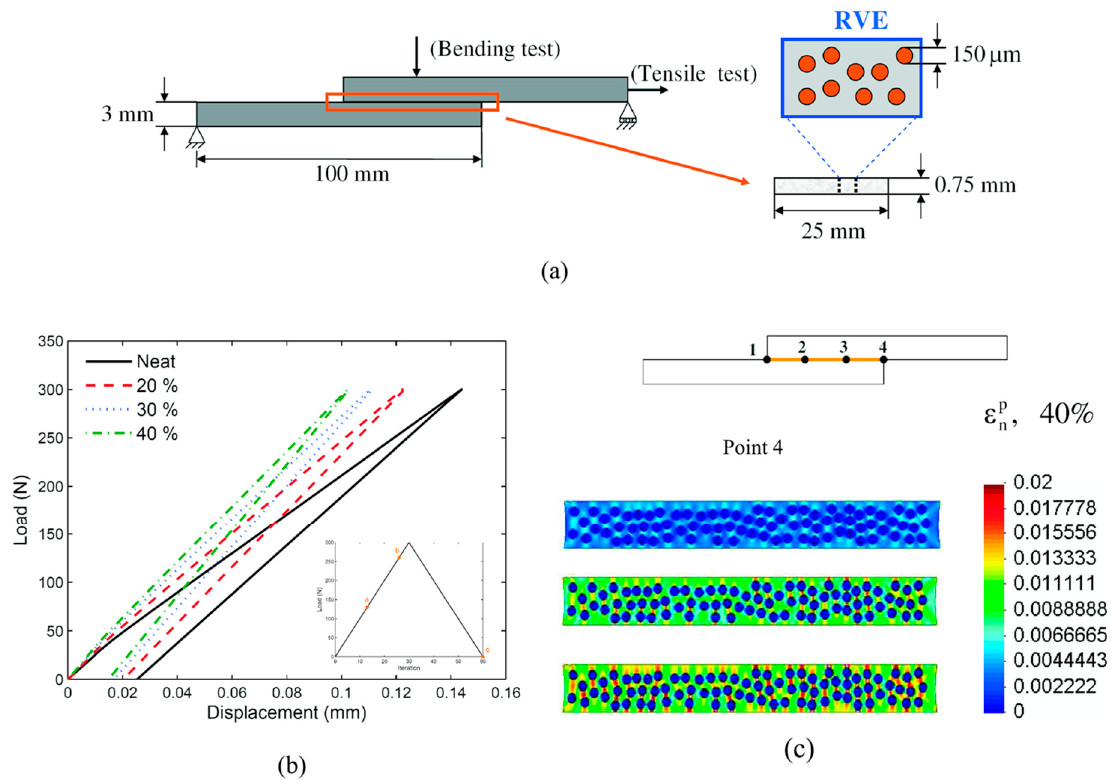
Figure 9. Multiscale analysis of heterogeneous adhesives. ( a ) Bending test macroscopic setup of a microstructurally reinforced adhesive. ( b ) Macroscopic traction-separation law in the normal direction, based on a multiscale analysis, for different concentrations of the inclusion and the bending loading included in the inset. ( c ) Microstructural distribution of the normal plastic microstrains for a 40% concentration of inclusions at the right corner side of the adhesive (point 4), at the three first stage levels of the macroscopic loading (inset in ( b )). (Figures taken with permission from [61]).